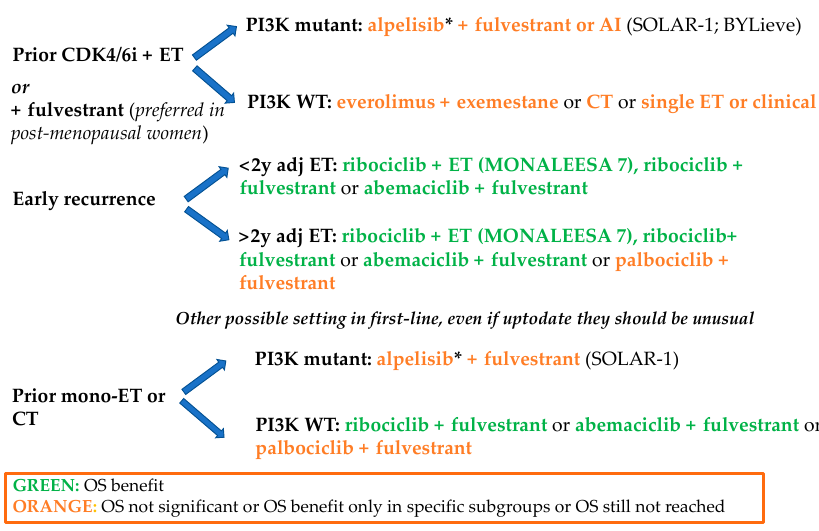
Figure 4. Proposed algorithm of HR+, HER2 − advanced breast cancer treatment. Abbreviations: CT, chemotherapy; ET, endocrine therapy with aromatase inhibitor or tamoxifen ± ovarian suppression; AI, aromatase inhibitor. *Alpelisib is recently approved only after disease progression following endocrine therapy as monotherapy.